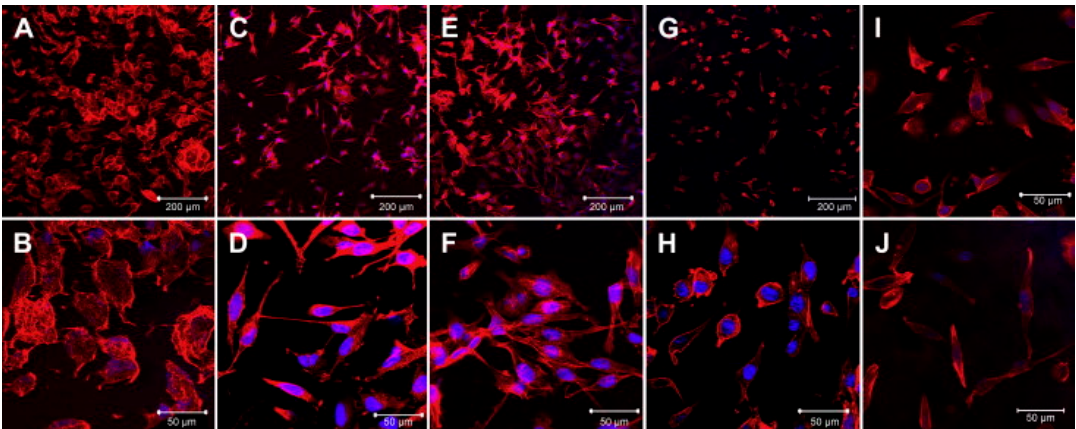
Figure 3. PC12 behavior on polypyrrole (PPy) / polycaprolactone (PCL) platform with various dopants. Cell proliferation on conductive polymer has been a ff ected by dopant type which dramatically a ff ect the cell proliferation, morphology and behavior. The di ff erent sca ff olds are ( A , B ) PCL, ( C , D ) PCL / PPY-NSA, ( E , F ) PCL / PPY-DBSA, ( G , H ) PCL / PPY-DOSS, ( I ) PCL / PPY-PI, ( J ) PCL / PPY-lysine.